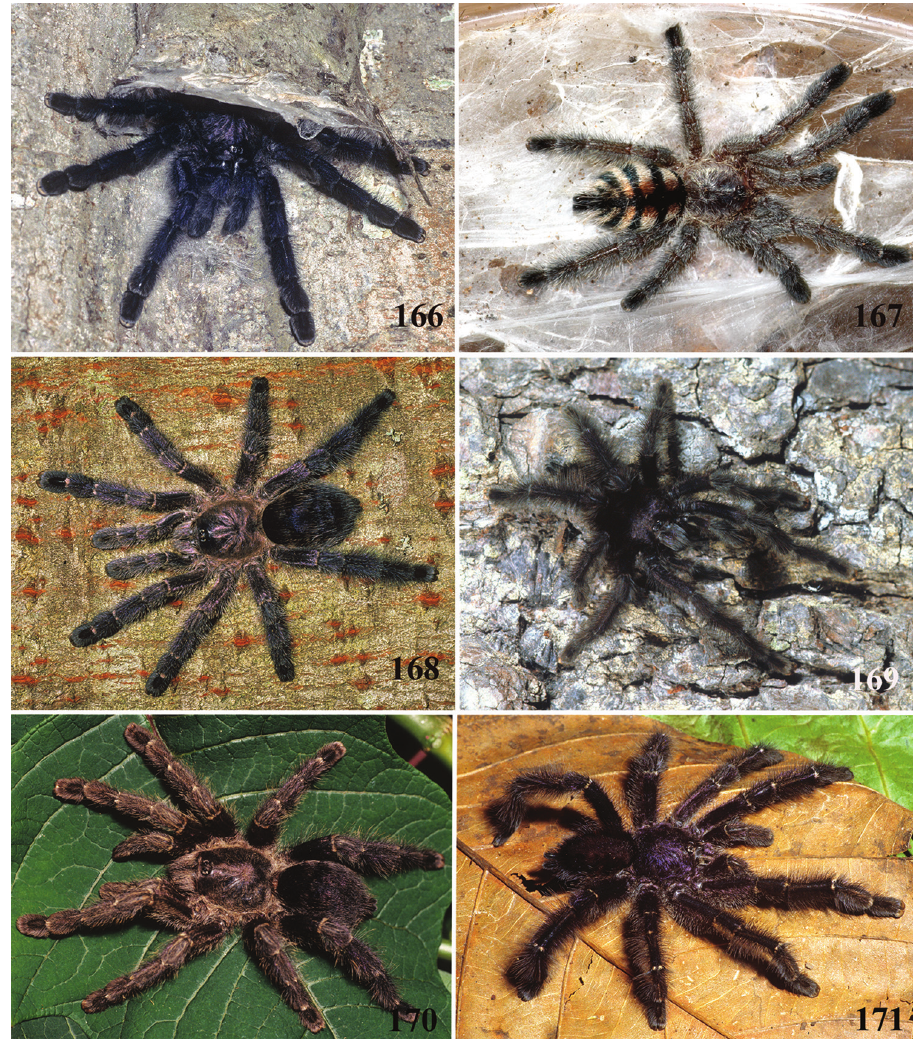
Legs: Length leg IV to leg I: 1.04. Scopula: Metatarsi IV scopulate in distal 1/4. IV divided by band of